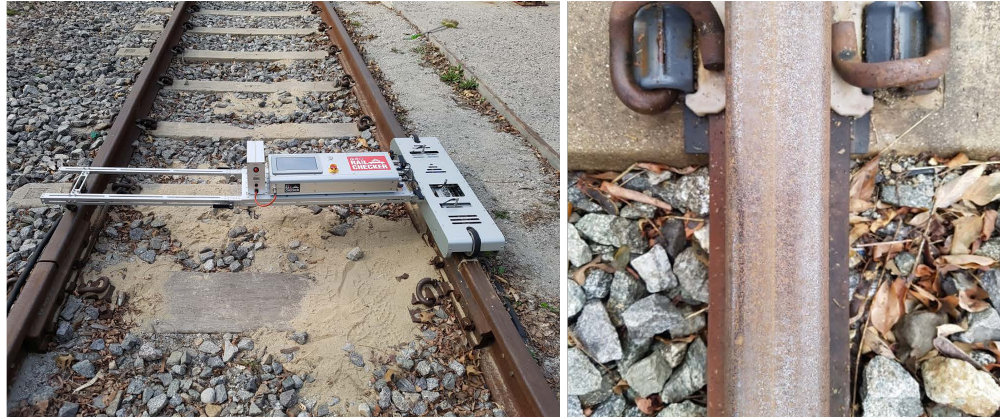
Figure 11. Field experiment on “Z”